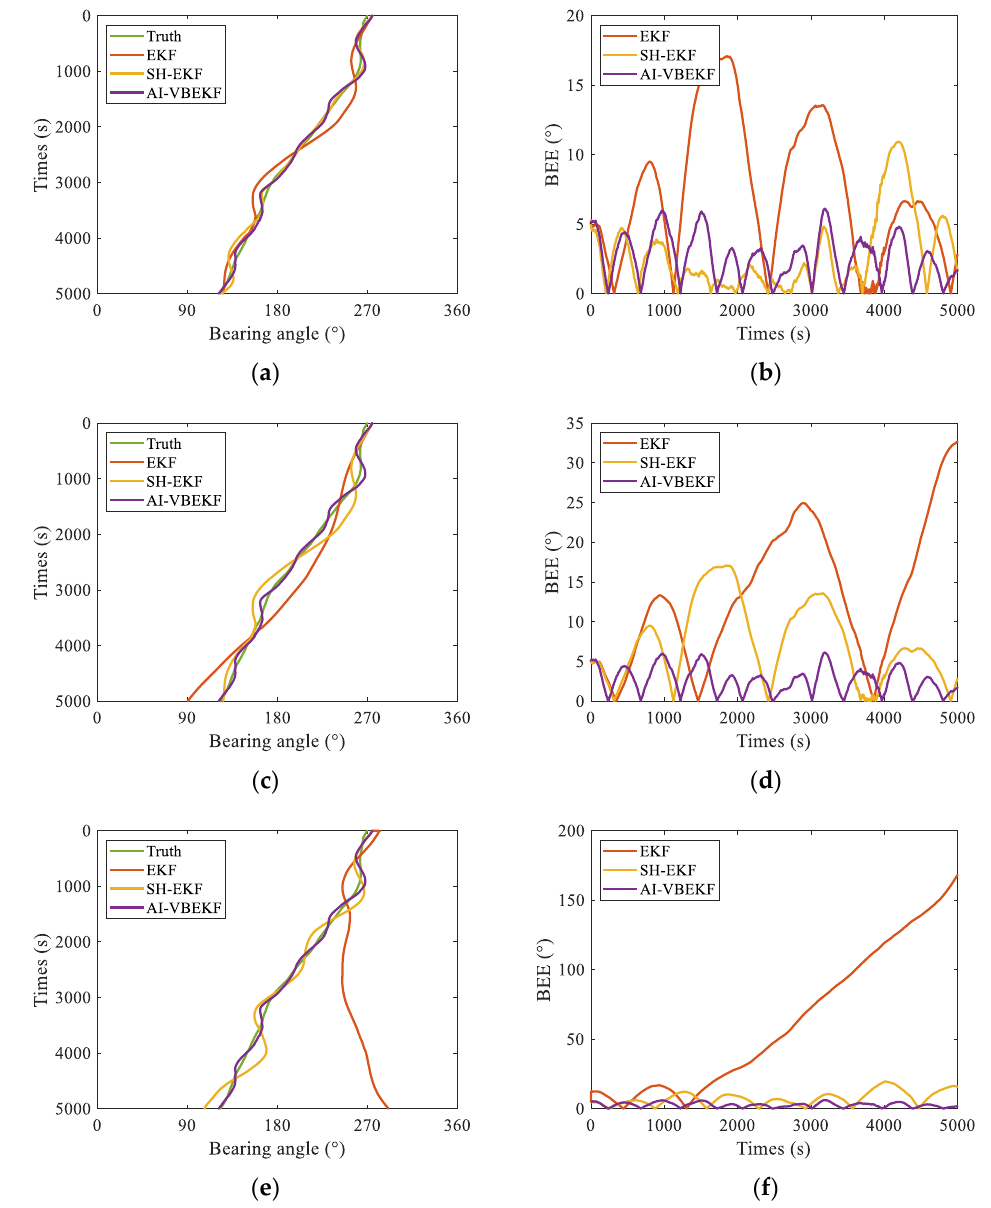
(cid:0) [ (cid:1) 25,10 − 5 ] , ( c ) trajectories tracking results (cid:0) [ (cid:1) 50,10 − 5 ] , ( e ) trajectories tracking (cid:0) [ (cid:1) 100,10 − 5 ] .